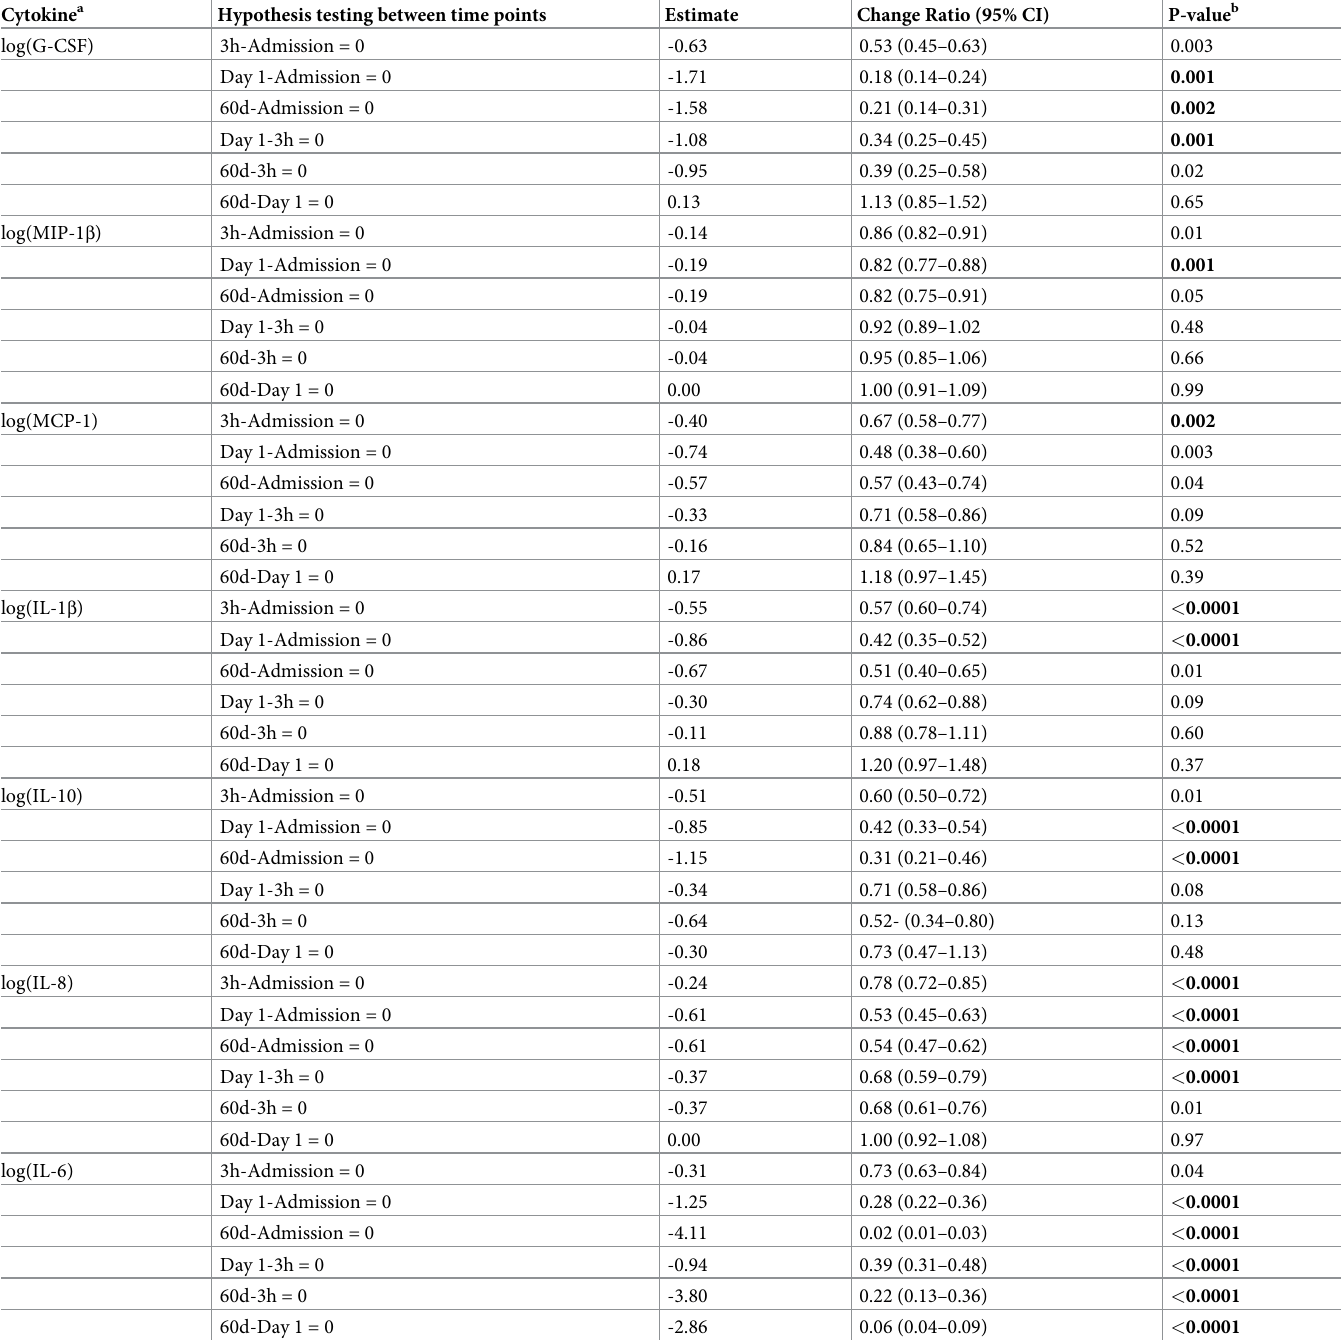
Table 6. Model estimates of relative log (cytokine concentrations) and the corresponding ratios of change between the sampling time points for cytokines with sig- nificant change effects. Cytokine